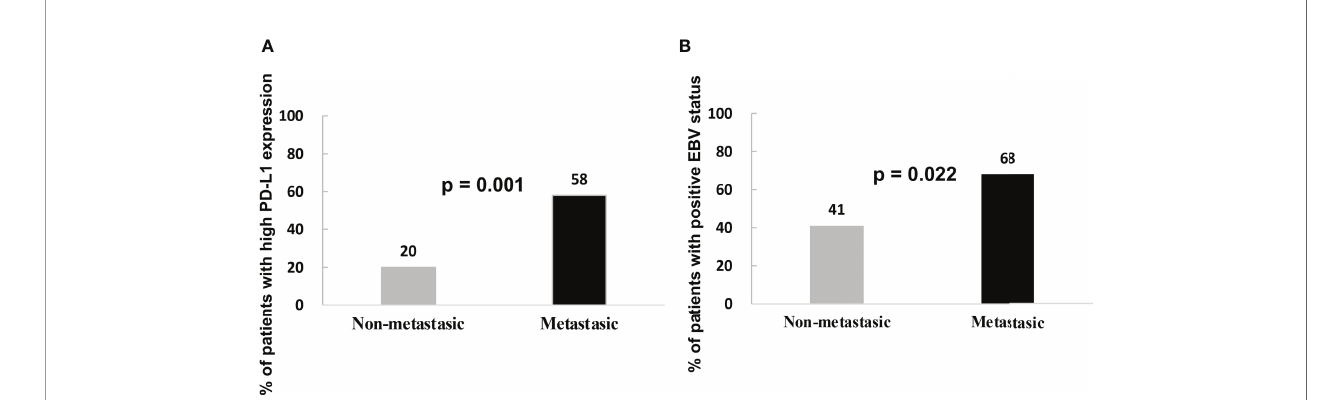
FIGURE 2 | (A) Percentage of metastatic and non-metastatic NPC patients with high PD-L1 expression levels at diagnosis. (B) Percentage of metastatic and non- metastatic NPC patients who were EBV-positive